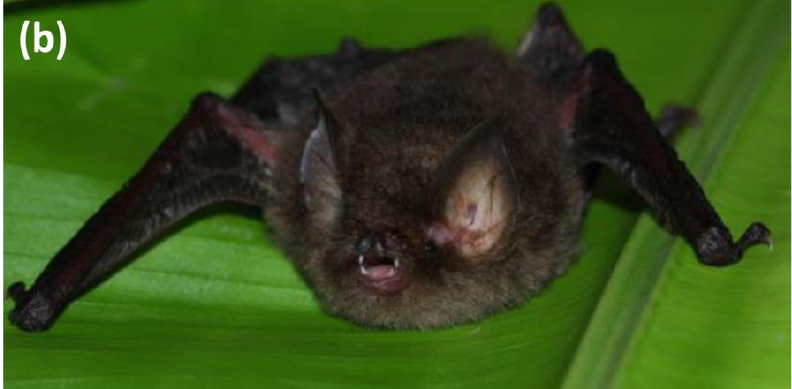
Figure 1. ( a ) Painted bat ( Kerivoula picta) (Male) ( Photo credit — Gayan Edirisinghe) and ( b ) Sri Lankan Woolly bat ( Kerivoula malpasi) (Male) (Photo credit — Madhava Botejue), both species roosting on Banana fronds .